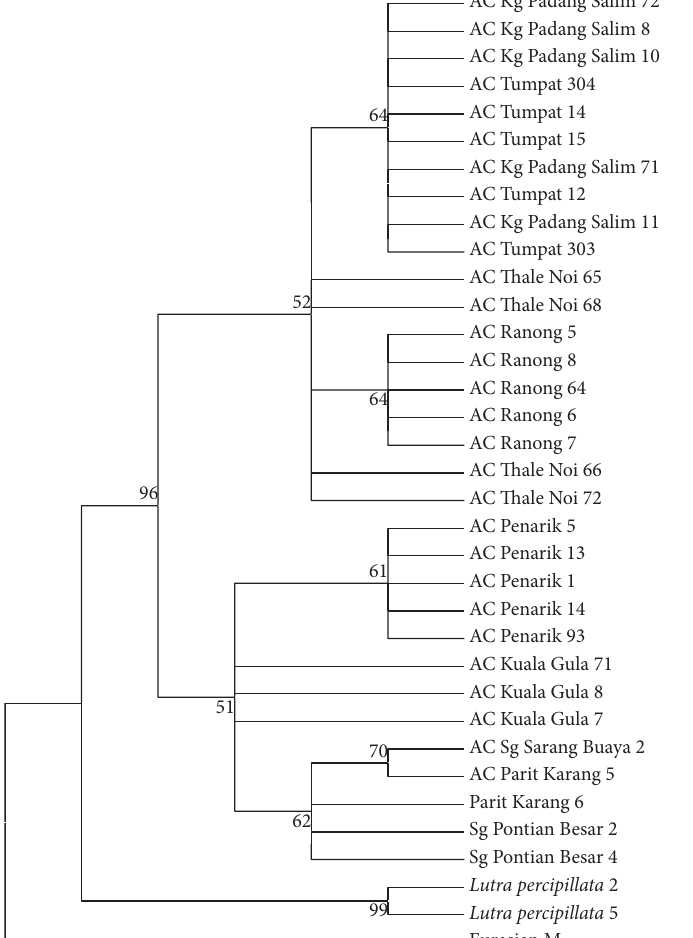
Figure 4: MP tree topology for studied samples. The number at the branches indicated the bootstrap values of 1000 replications.